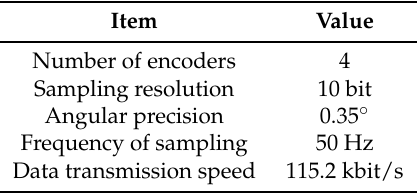
Table 2. Joint angle sensing specifications.